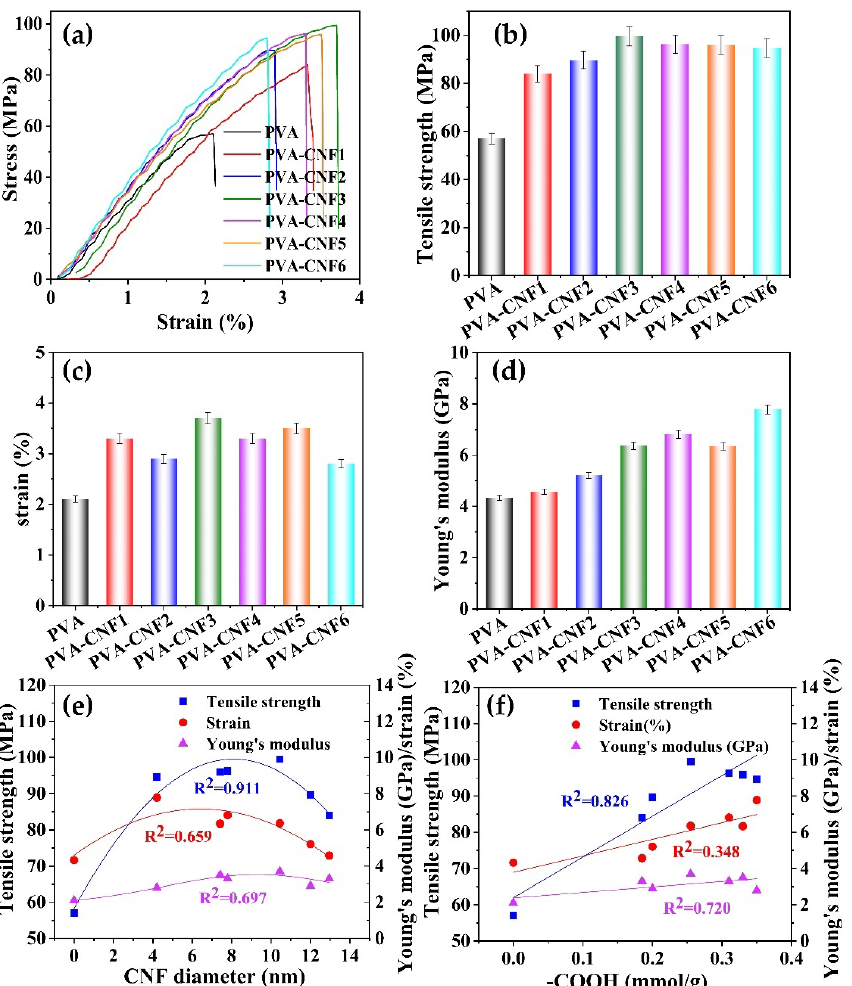
Figure 4. Mechanical properties of the pure PVA and composite films. ( a ) Stress; ( b ) tensile strength; ( c ) strain; ( d ) Young’s modulus; ( e ) relationship between the CNF diameter and mechanical properties of the composite films; ( f ) relationship between the carboxyl group content and mechanical properties of the composite films.